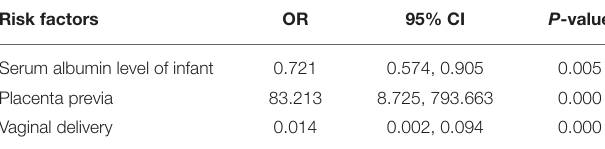
TABLE 5 | Logistic analysis of multi-factor for late-preterm neonatal